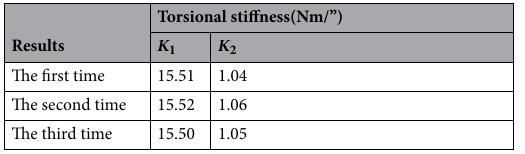
Table 1. The torsional stiffness and backlash of the RV-40E